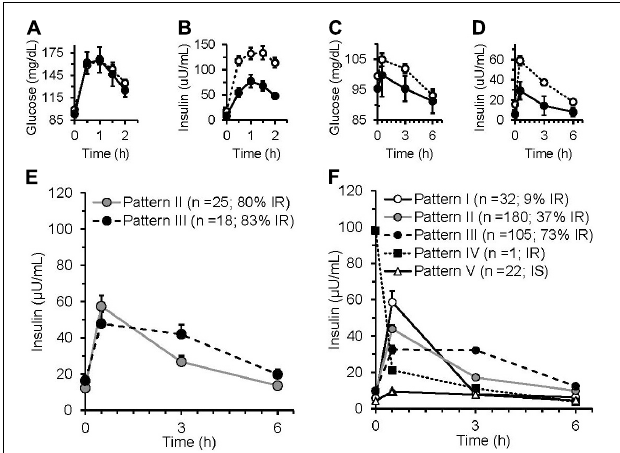
FIGURE 2 | Glucose and insulin responses of insulin-sensitive and insulin-resistant iMAPS participants to a 75 g glucose oral glucose tolerance test (OGTT) and a 50 g sucrose containing mixed macronutrient meal challenge test (MMTT). The OGTT (A) glucose and (B) insulin responses of participants identified as insulin sensitive ( n = 8) or insulin sensitive ( n = 35) by the 2 h ISI Composite . The MMTT (C) glucose and (D) insulin responses of the participants identified as insulin sensitive ( n = 10) or insulin sensitive ( n = 33), the 3 h ISI MMTT . In panels (A–D) : • = insulin sensitive; ◦ = insulin resistance. (E) iMAPS participant MMTT-dependent postprandial insulin response patterns. (F) Phenotyping participant MMTT-dependent postprandial insulin response patterns. Postprandial response patterns were adapted from previously reported 4 h OGTT-dependent insulin response patterns (29–31).